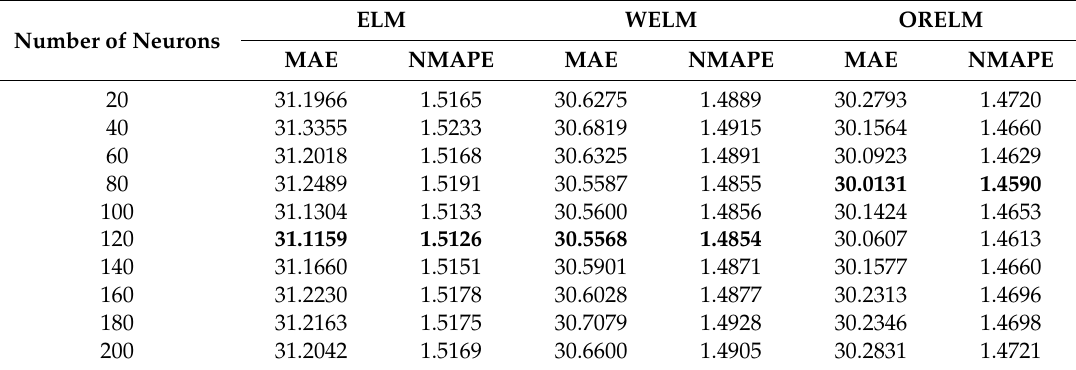
Table 4. Power curve modeling results of ELM-based models on validation set of Dataset A. Number of Neurons